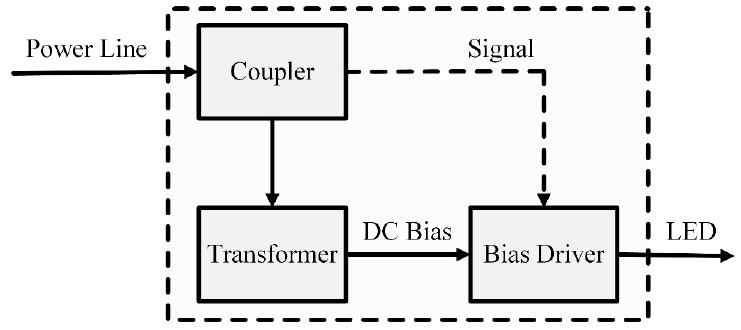
Figure 4. PLC to IWOC module [19].